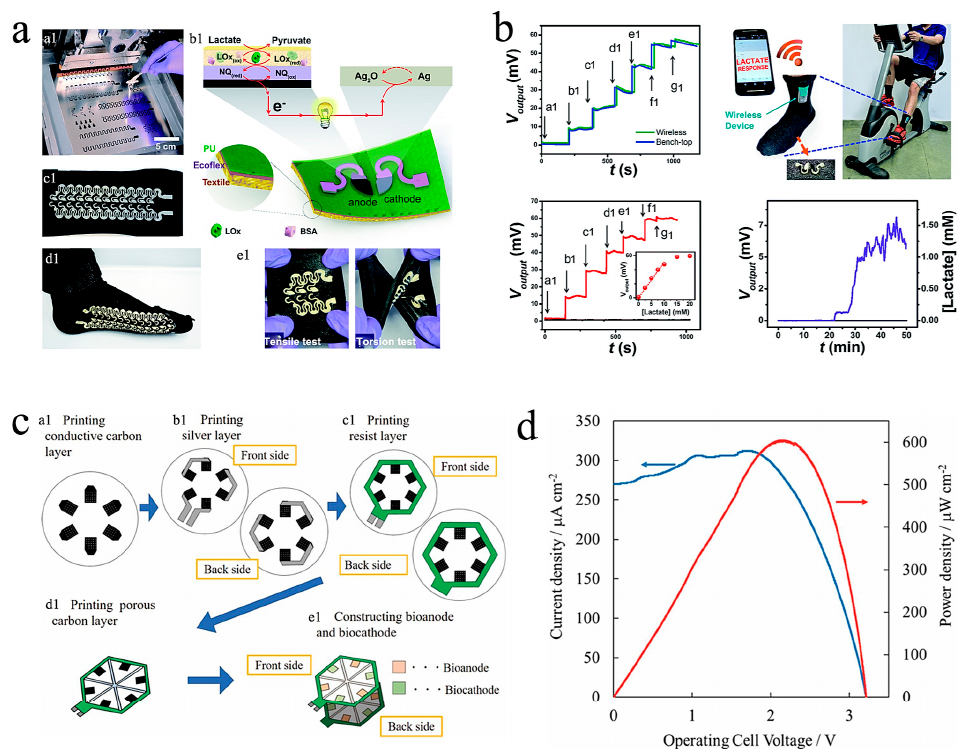
Figure 3. ( a ) Digital photograph and working principle of the wearable µ -EBFC-SPB fabricated using screen-printing technology; ( b ) Sensor’s flexibility tests and the ability of this sock-based biosensor to monitor lactate online [57] Copyright 2016 Royal Society of Chemisty. ( c ) Schematic diagrams of the screen-printed EBFC array; ( d ) the output performance of this EBFC array [58]. Copyright 2019 Electrochemical